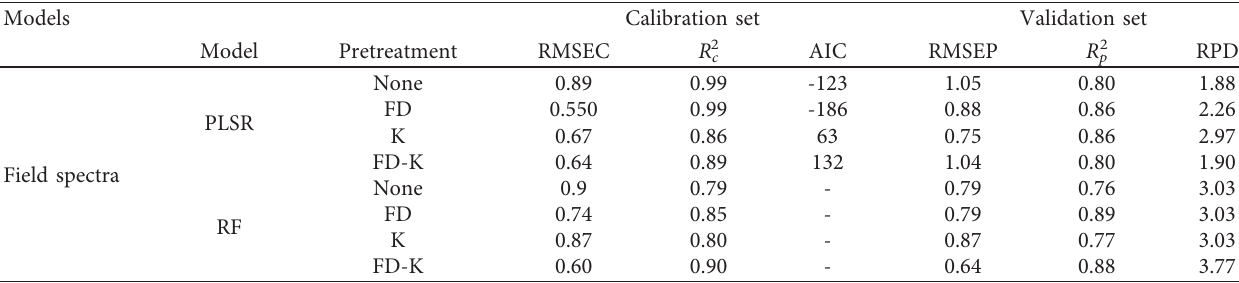
Table 4: Performance of all RF regression and PLSR models in the calibration and validation field datasets (RMSEC and RMSEP in g 100g − 1